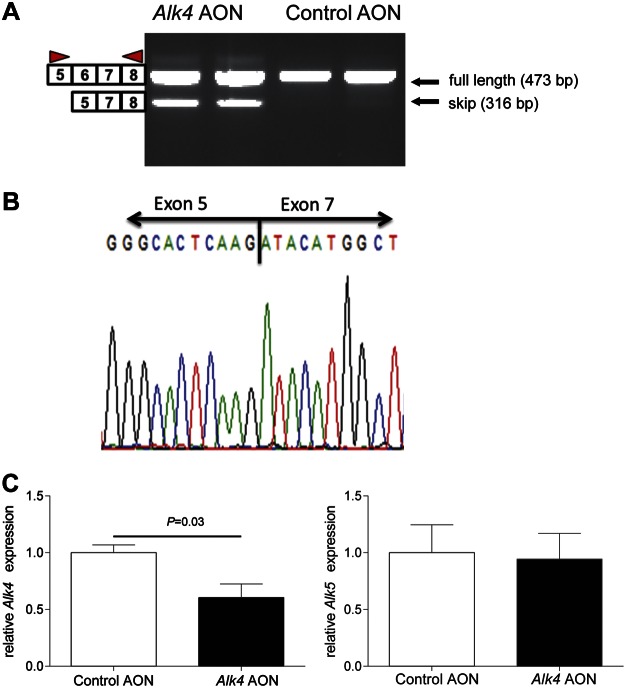
Alk4 AON targets the out-of-frame exon 6 and results in efficient exon 6 skipping and Alk4 knockdown in C2C12 myoblasts. A) AON targeting exon 6 of Alk4 (Alk4 AON) and scrambled control AON were transfected at 100 nM concentration into C2C12 murine myoblasts. RNA was isolated after 24 h, and the efficiency of exon-skipping induction was measured by RT-PCR using Alk4-specific primers in flanking exons (arrowheads). B) Sequencing of the PCR products showed exclusion of the target exon 6 (exon 6 skip). C) qPCR was performed to measure full-length Alk4 transcript expression using primers in the skipped exon to assess Alk4 transcript down-regulation. Alk5 transcript expression was measured by qPCR and remained unchanged in Alk4 AON-treated C2C12.The data are presented as the average of the results of 3 independent experiments normalized to Gapdh and are shown relative to control AON samples. Error bars, sd.